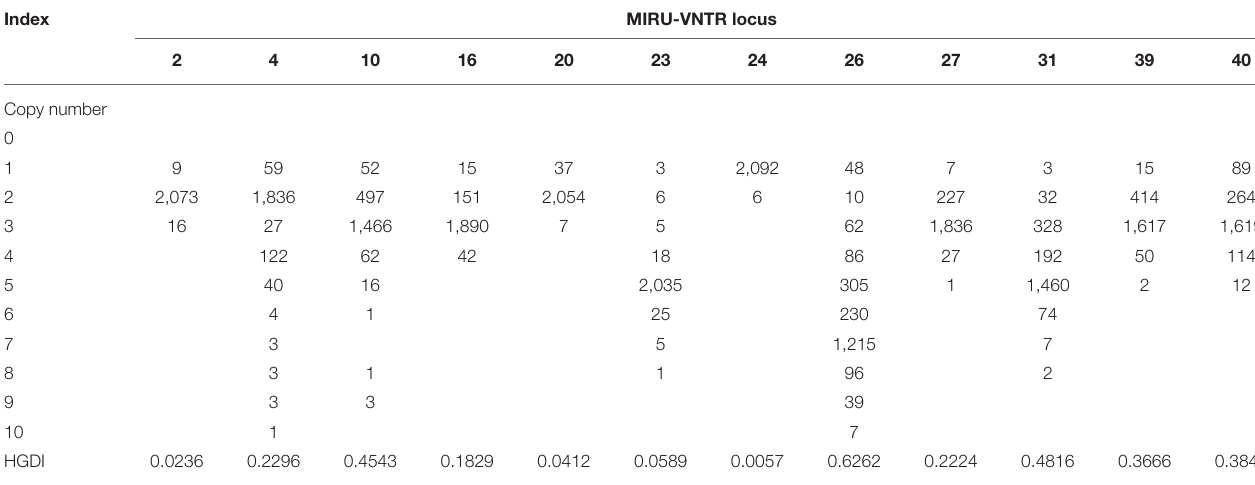
TABLE 2 | Resolution of each polymorphic site for 2,098 isolates.